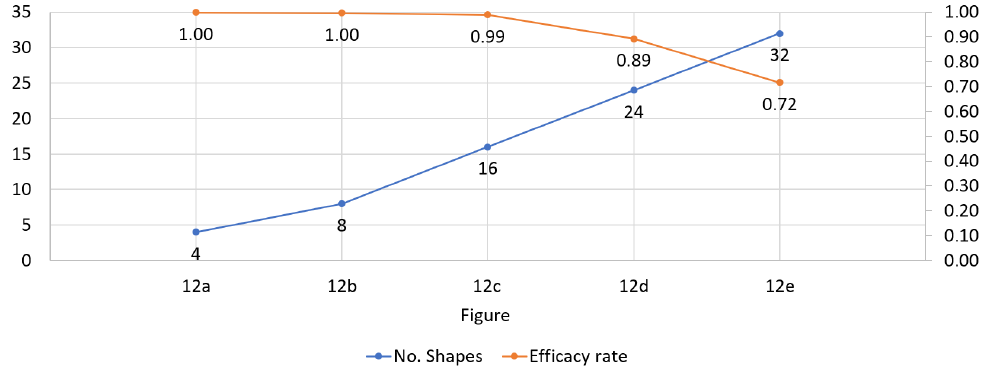
Figure 14. Circle detection hit rate response to increasing the number of figures around a single circle in synthetic